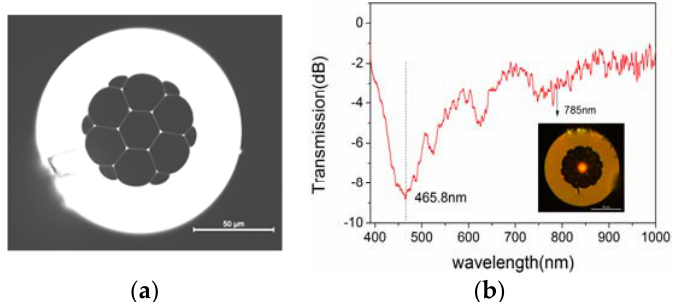
Figure 1. ( a ) Cross ‐ section of the SHC ‐ PCF; ( b ) Transmission spectrum of a 10 ‐ cm SHC ‐ PCF